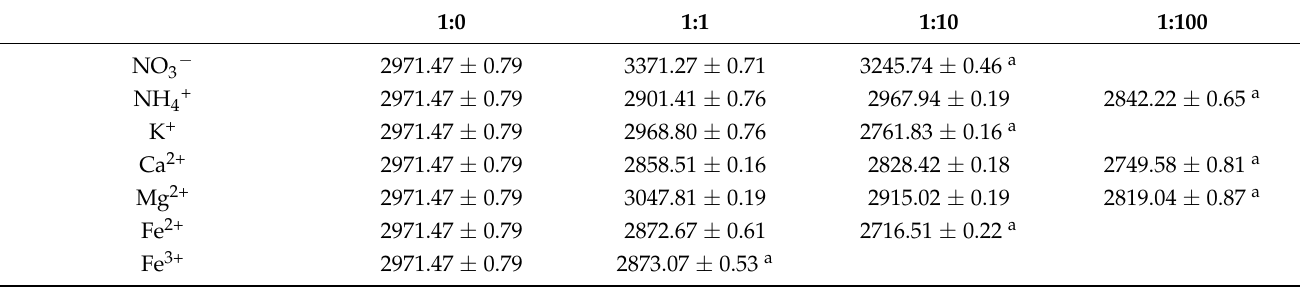
Table 1. The reflectance intensity reading obtained from the developed microbial optosensor for the determination of 20 mg L − 1 nitrite in the presence of common nutrient ions found in processed meats ( n = 3). Reflectance Intensity at Concentration Ratio between Nitrite and Potential Interfering Species, 608 nm